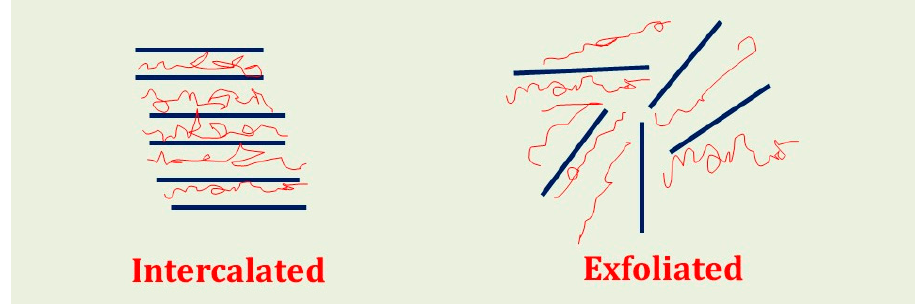
Figure 2. Schematically illustration of intercalated and exfoliated morphologies displayed by polymer/layered silicate nano-composite.